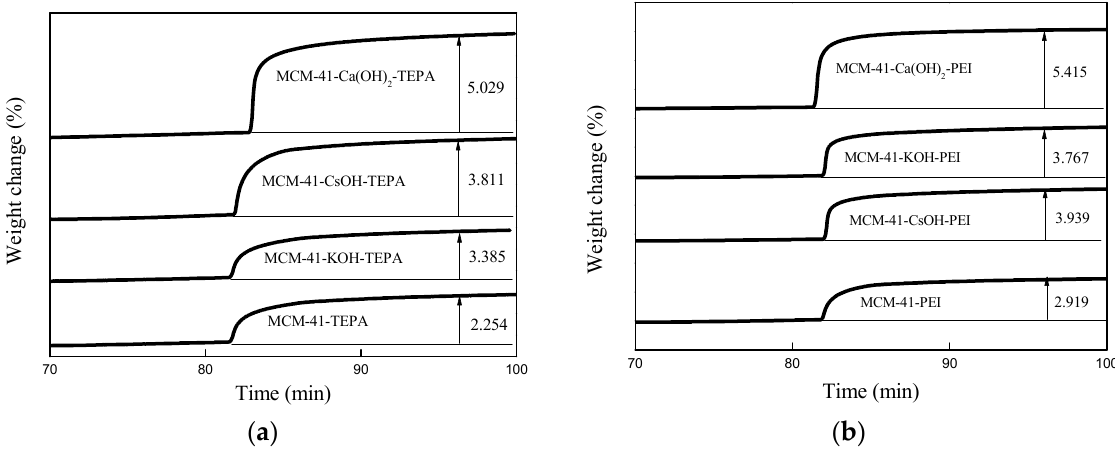
Figure 5. CO 2 adsorption curves of ( a ) TEPA ( b ) PEI and various inorganic alkali ‐ modified adsorbents.